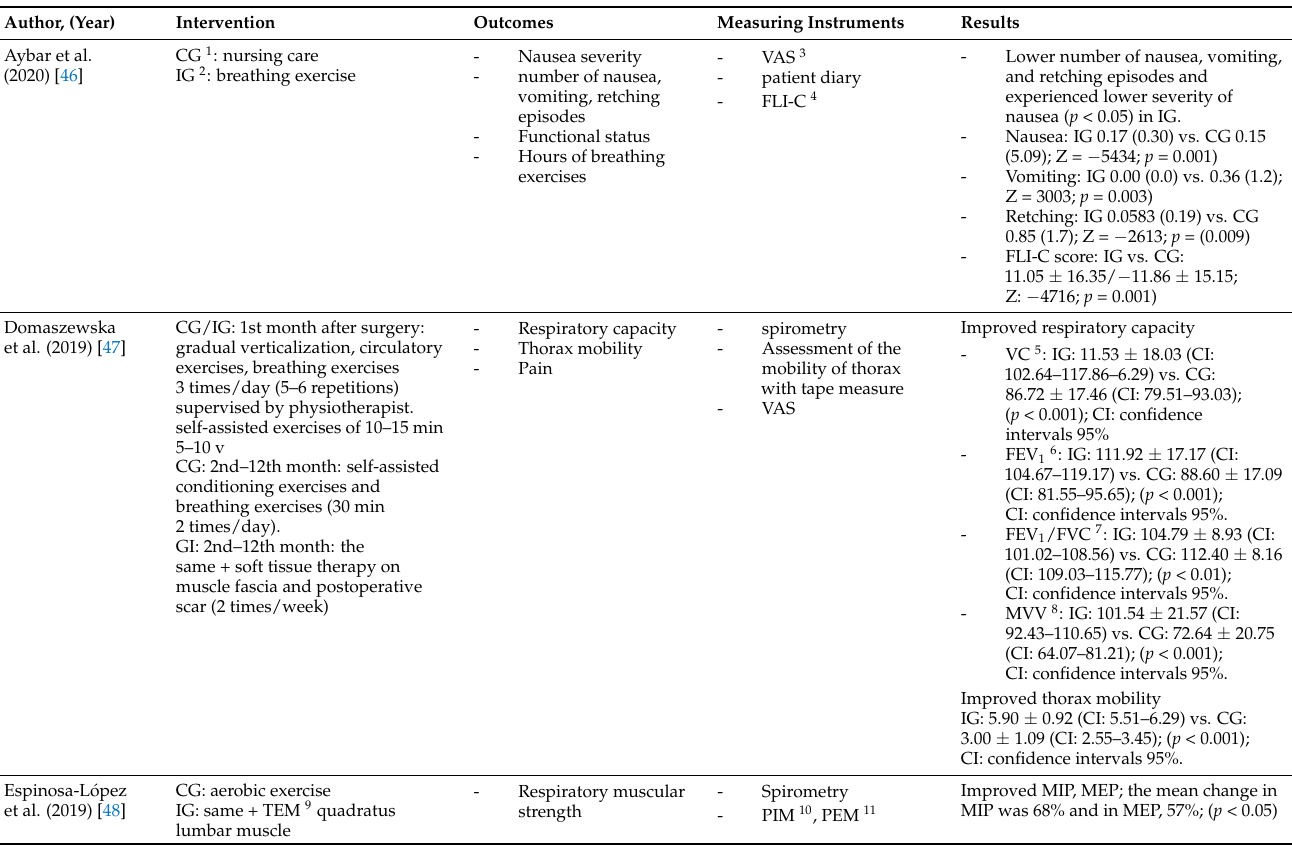
Table 1. Characteristics of the study